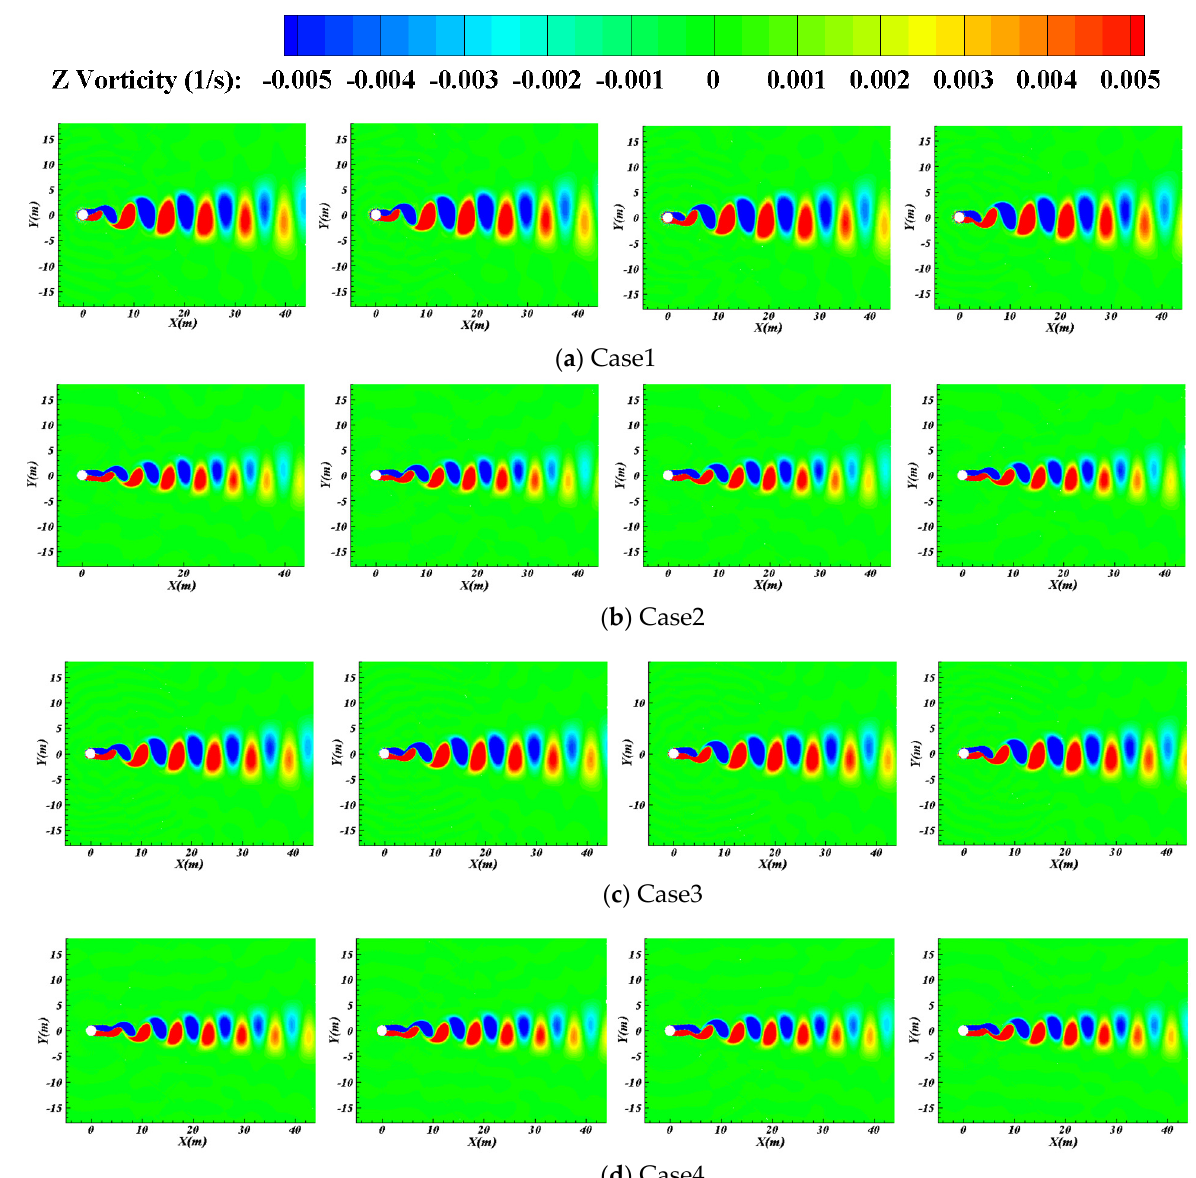
Figure 12. The Z vorticity distribution of the period time T = 0.425.